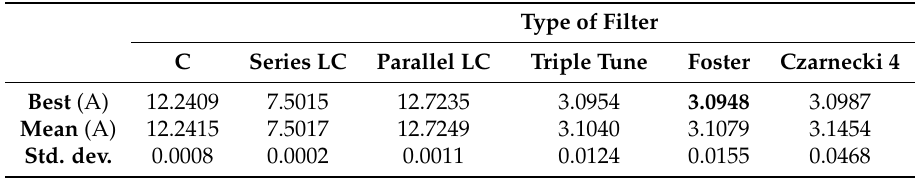
Table 1. Compensated root mean square (RMS) current ( I scp ) obtained by the genetic algorithm in Czarnecki’s case study [39].